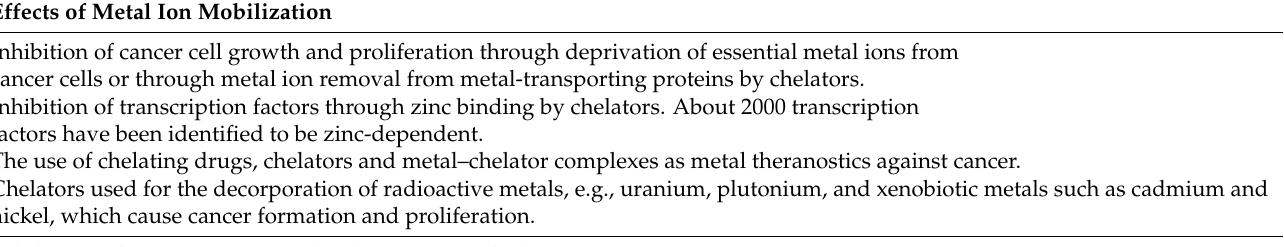
Table 2. Examples of possible uses of chelating drugs and metal complexes in cancer